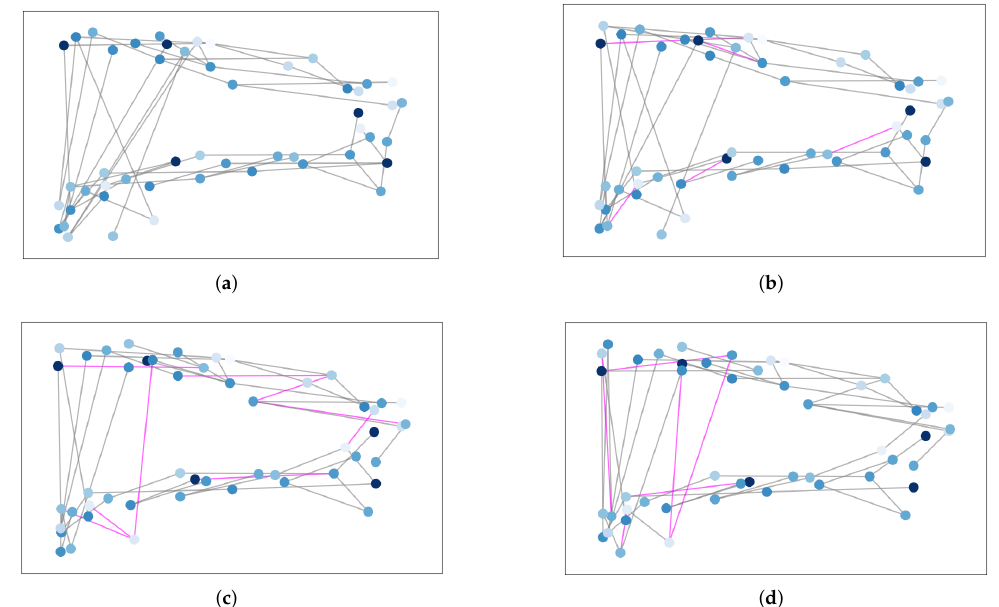
Figure 3. Dynamic MST. A 50-vertices star-link graph in four states one second apart. The magenta edges are the new edges that were added from the previous states. The vertices are colored differently so that the graph motion is easier to track. ( a ) MST in time 0. ( b ) MST in time 1. ( c ) MST in time 2. ( d ) MST in time 3.